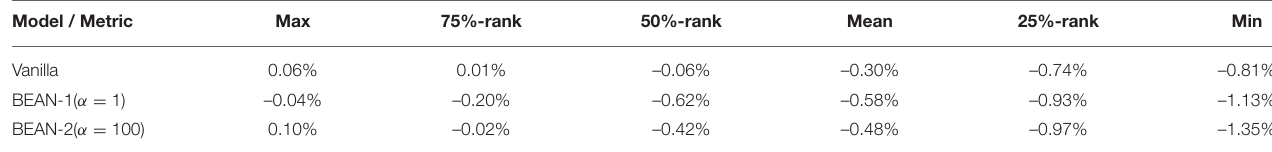
TABLE 3 | Statistic of data values test set error rate-validation set error rate on 10-shot learning on the MNIST dataset from 20 random runs. Model /